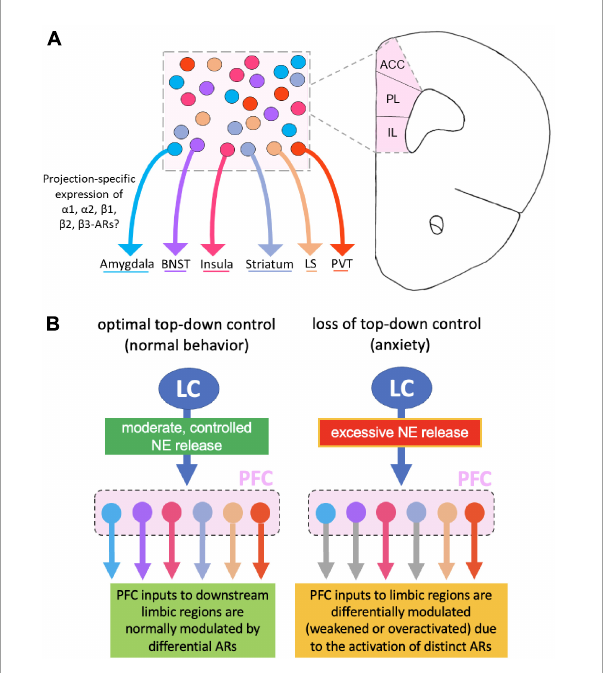
FIGURE5 Norepinephrine (NE) modulation of distinct prefrontal cortical neurons that project to different anxiety-related subcortical regions. (A) The prefrontal cortex (PFC) sends dense projections to numerous brain regions implicated in anxiety, yet there is currently no research on which NE receptor subtypes exist on these output pathways. (B) Left panel: Potential circuit-based mechanisms by which optimal locus coeruleus (LC)-mediated NE release in the PFC modulates different PFC output circuits through activation of differential adrenergic receptors (ARs). Right panel: Excessive NE release weakens or over activates PFC outputs to the downstream limbic regions, depending on projection-specific activation of distinct AR subtypes. This in turn results in a shift of dynamic balance among the different circuitries, leading to a loss of prefrontal top-down control and the production of an anxiety-like